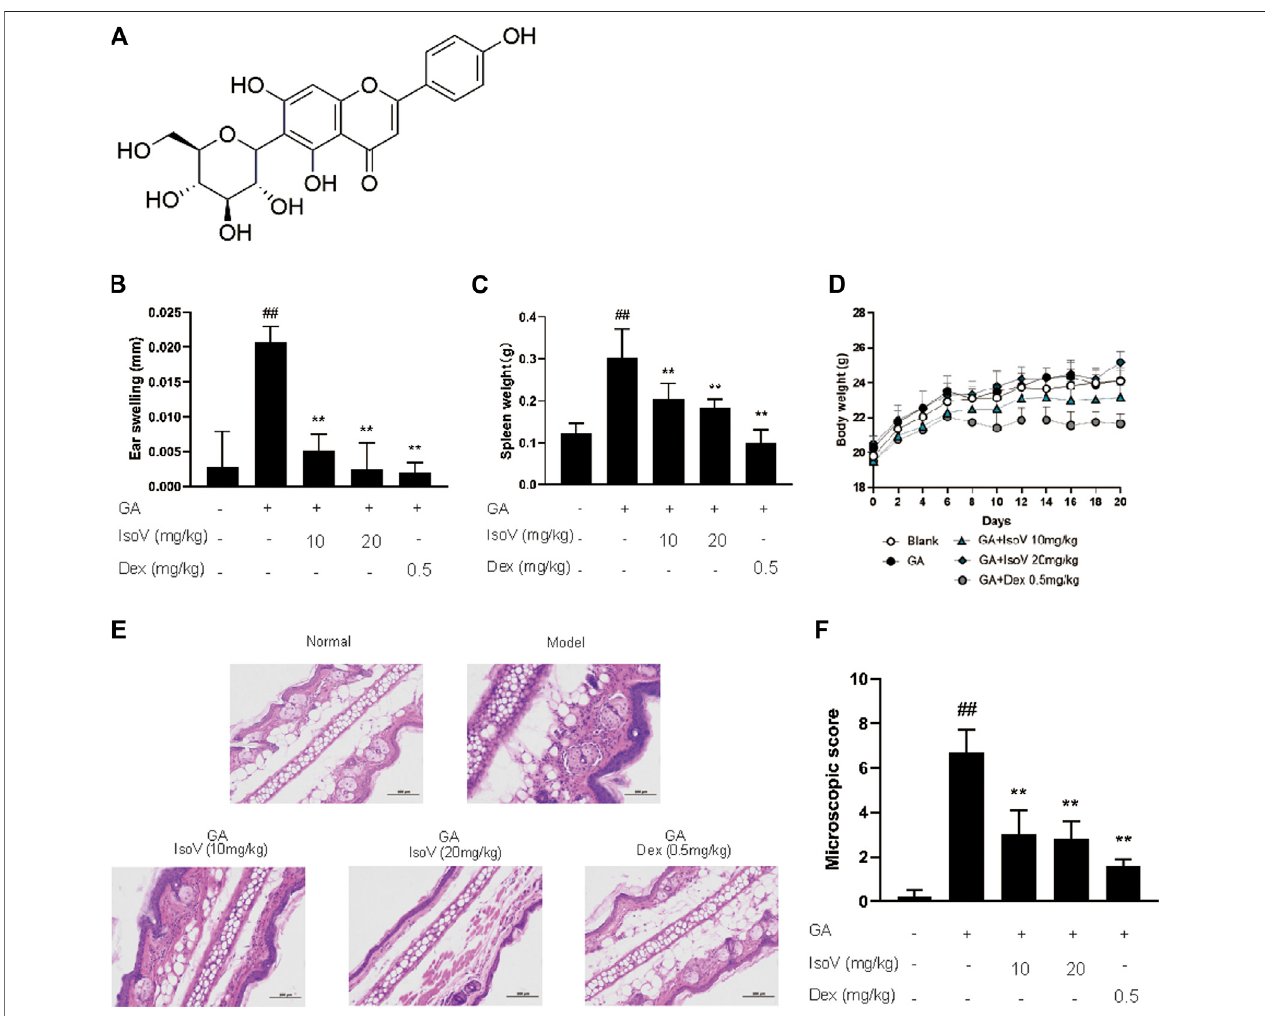
FIGURE 2 | Celtis sinensis leaf Extract (CLE) ameliorates ginkgolic acids (GA)-induced contact dermatitis in mice. (A) The mouse model of GA-induced contact dermatitis, drugs were administered once a day from day 6 to day 20. (B) The mice were given CLE at 100 and 200 mg/kg respectively, and the ear swelling was measured24 hafterchallengeatday20. (C) Spleenweightwasmeasuredatday20. (D) Thebodyweightchangesofmiceindifferentgroups. (E) Hematoxylinandeosin stain (original magni fi cation × 200) of ear tissue sections. Bars, 100 µm. (F) Ear histological scoring. Data represent means ± SEM of eight mice. ## p < 0.01 vs. vehicle group, * p < 0.05, ** p < 0.01 vs. model